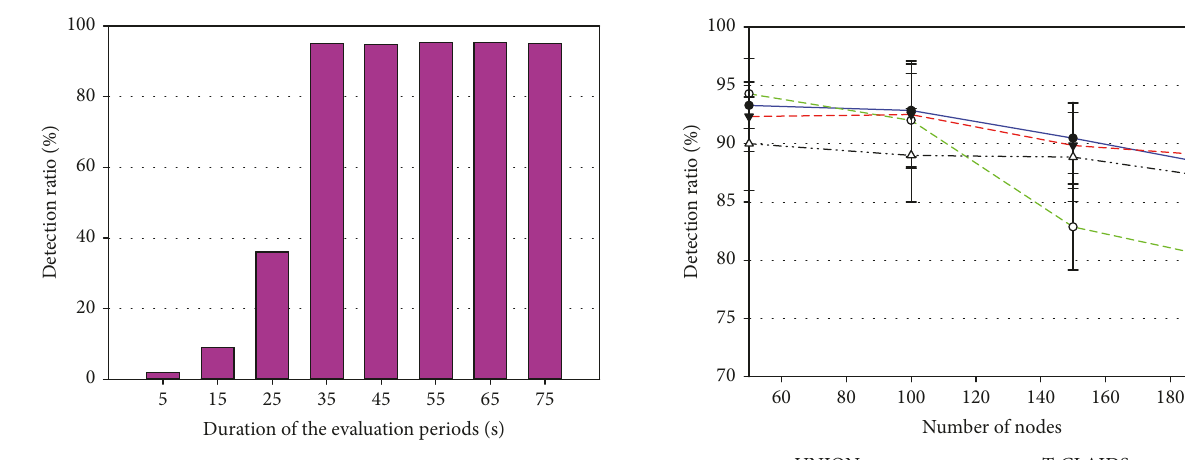
Algorithm 5: Inter-UAV packet delivery process.